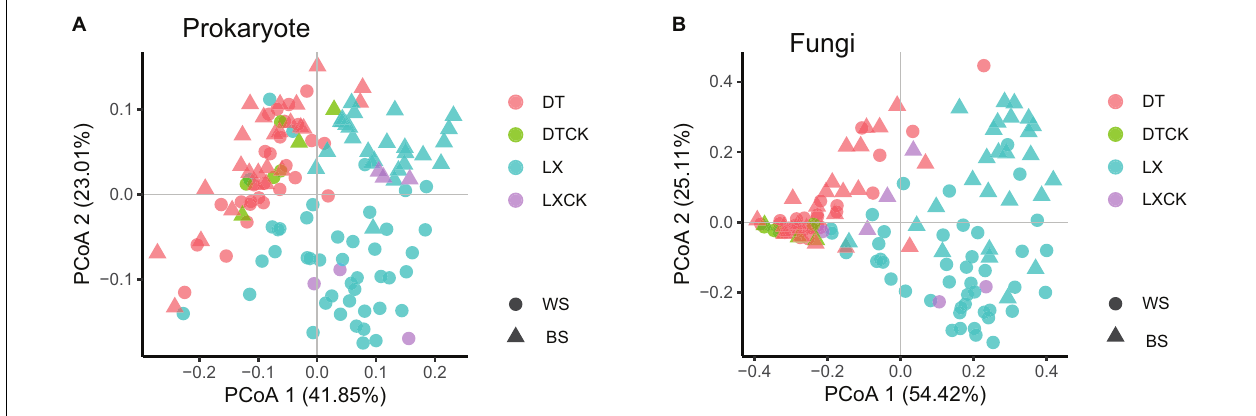
FIGURE 3 | (A,B) Principal coordinate analysis (PCoA) of prokaryote and fungi based on the Bray–Curtis distance between the bulk soil ( n = 13) and rhizosphere soil ( n = 122) for each location using the metagenomic data. WS, Wenshan City; BS, Baise City; DT, cropland planting rhizosphere soil; DTCK, cropland planting bulk soil; LX, understory planting rhizosphere soil; LXCK, understory planting bulk